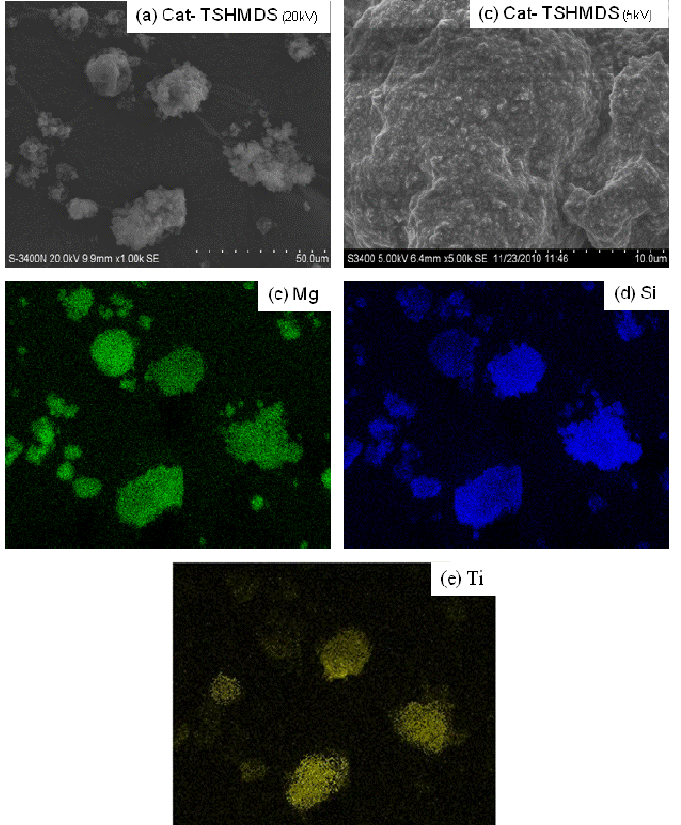
Figure 7. SEM micrograph and elemental distribution on Cat-TSHMDS; (a) SEM